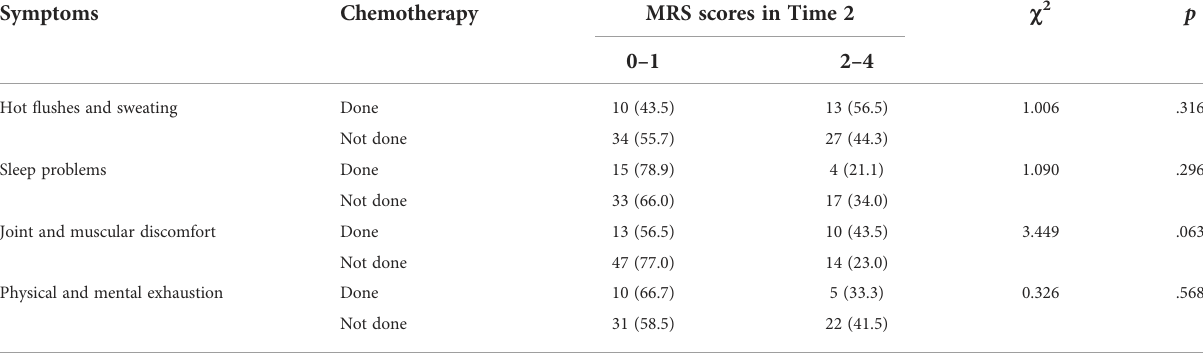
TABLE 4 Menopausal-symptom scores at Time 2 according to chemotherapy in patients who reported “ no symptom-to-mild ” scores at Time 1. Symptoms